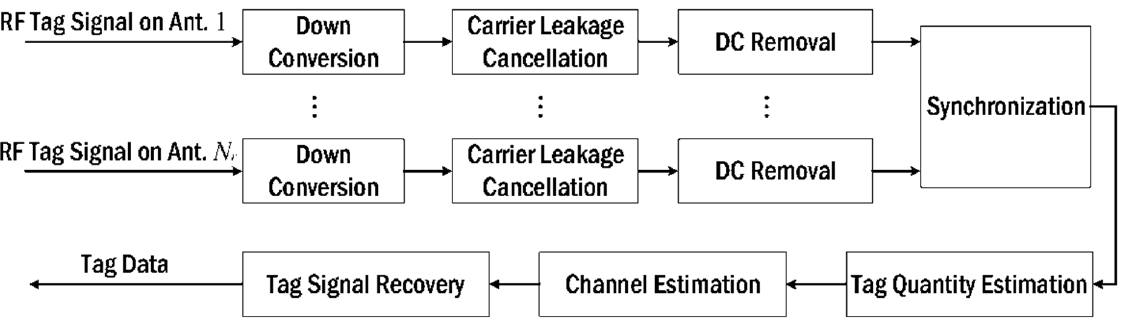
Figure 6. Flowchart of the tag recovery scheme. Reproduced from [45] with permission from IEEE.